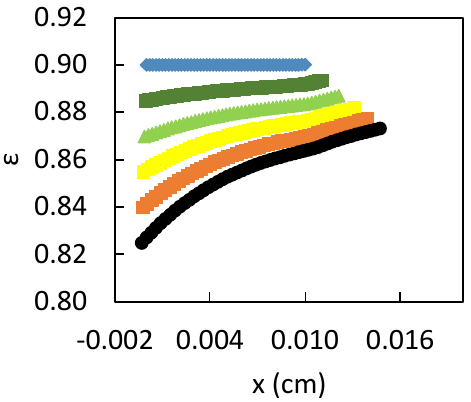
Figure 11. Evolution of the porosity of the CPL in an electrolyte of 1000 mol/m 3 HCl of a size L = 10 cm with an initial CPL of 100 µm as a function of time (s) presented for different times t = 0 s (light blue), 3600 s (dark green) 7200 s (green), 10,800 s (yellow), 14,400 s (orange), and 18,000 s (black).